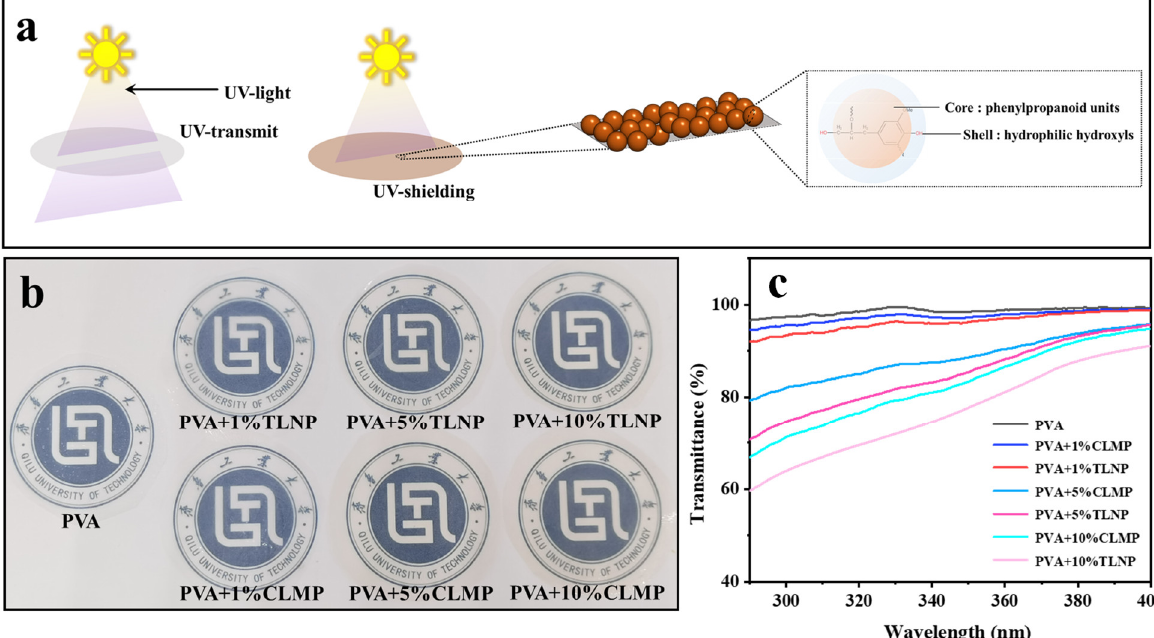
Figure 8. ( a ) Anti-UV mechanism diagram; ( b ) physical picture of PVA film with different lignin content; and ( c ) UV transmission diagram of different membrane materials.